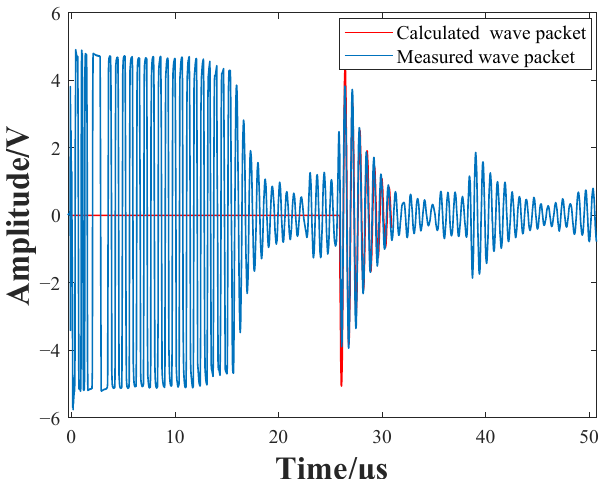
Figure 10. Theoretical calculation pulses and measurement-signals fitting results.